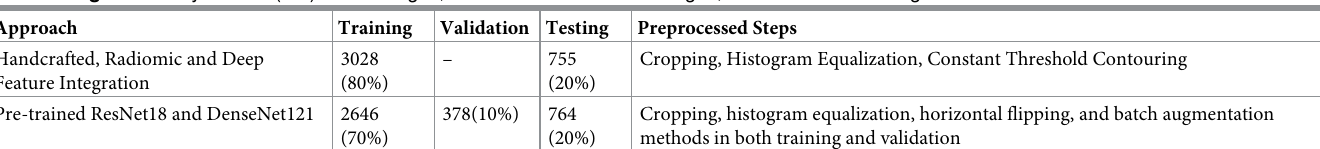
Table 1. CXR data information.